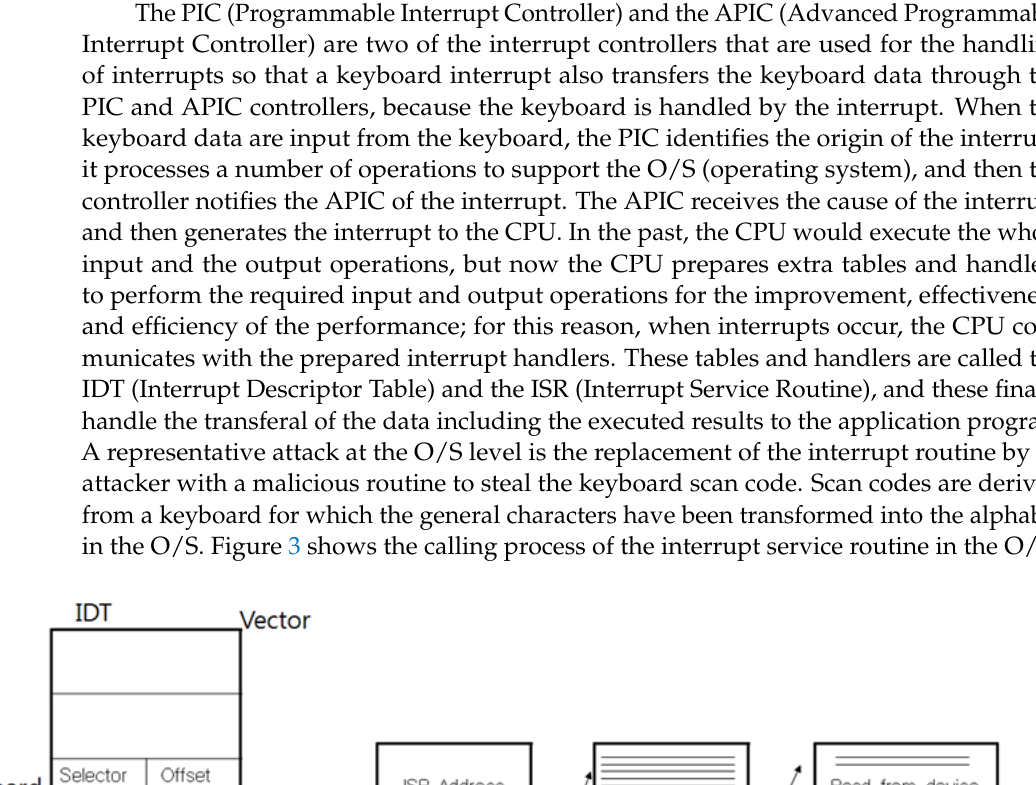
Figure 2. Transferal process of the keyboard data .